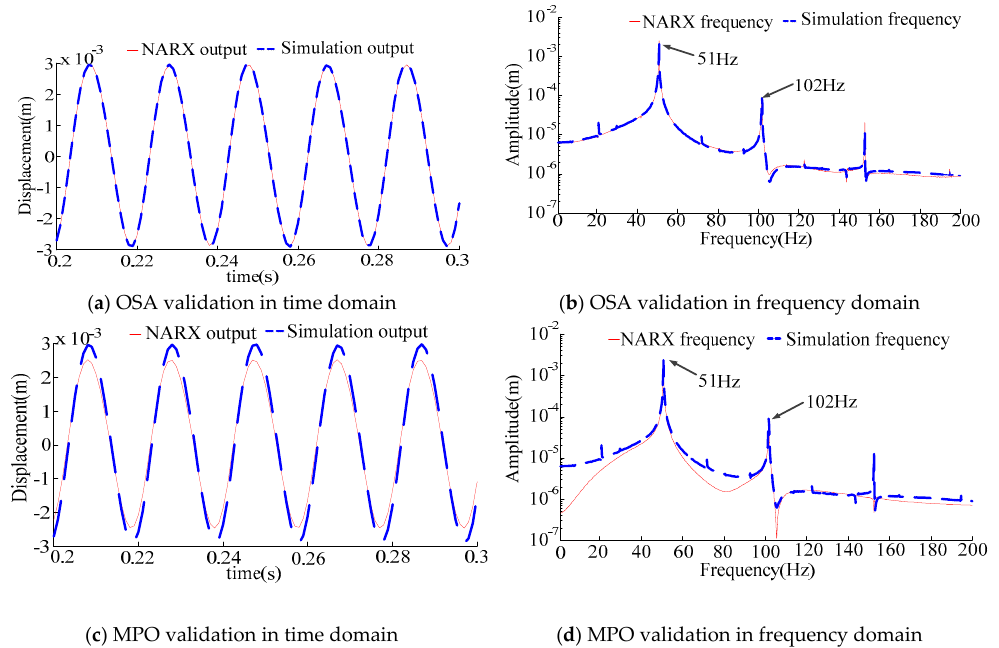
Figure 7. Output comparison in time and frequency domain when (cid:2033) = 320 rad/s.